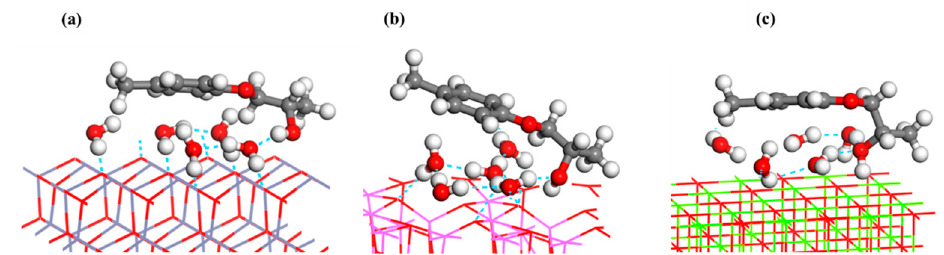
Figure 12. Stable adsorption structure of adhesive on ( a ) ZnO(10-10), ( b ) Al 2 O 3 (100), and ( c ) MgO(100) surfaces in the water model.